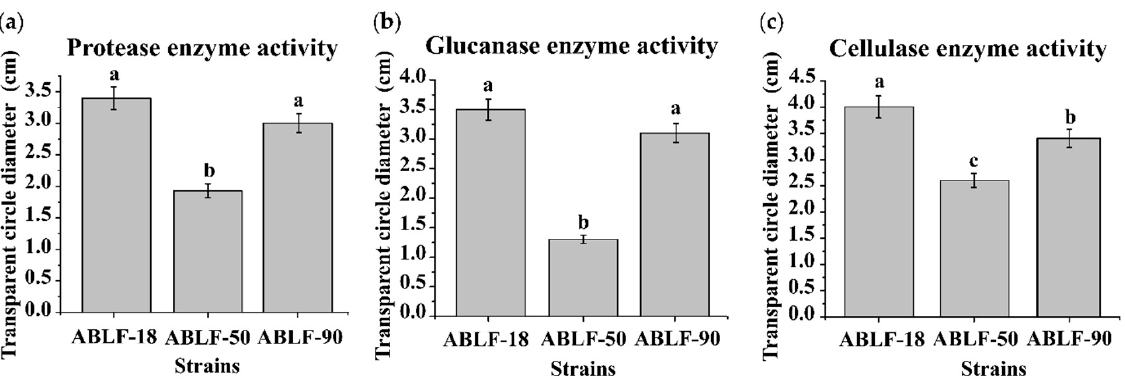
Figure 4. Extracellular enzyme activity analysis. The protease enzyme activity ( a ), glucanase enzyme activity ( b ) and cellulase enzyme activity ( c ) were tested on different medium. Different letters represent significant differences at p < 0.05 by Duncan’s test.